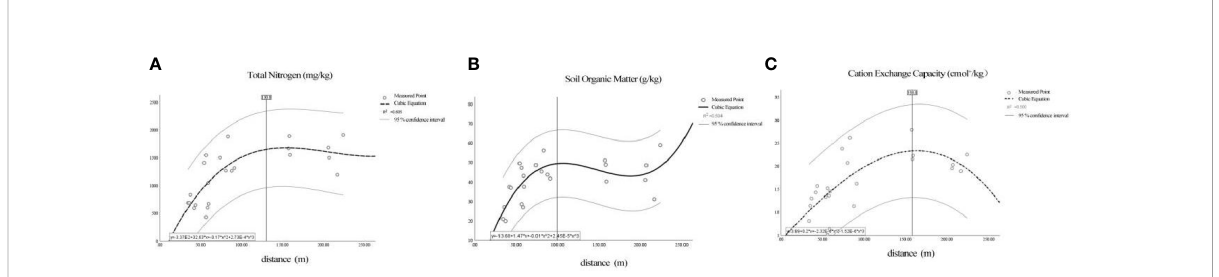
FIGURE 7 Fit image of ecological chemical indices and distance. The regression function ’ s upper and lower dashed lines are the 95% con fi dence intervals of the regression function, including all measurement points. (A – C) are the regression images of TN, SOM, CEC (respectively) and